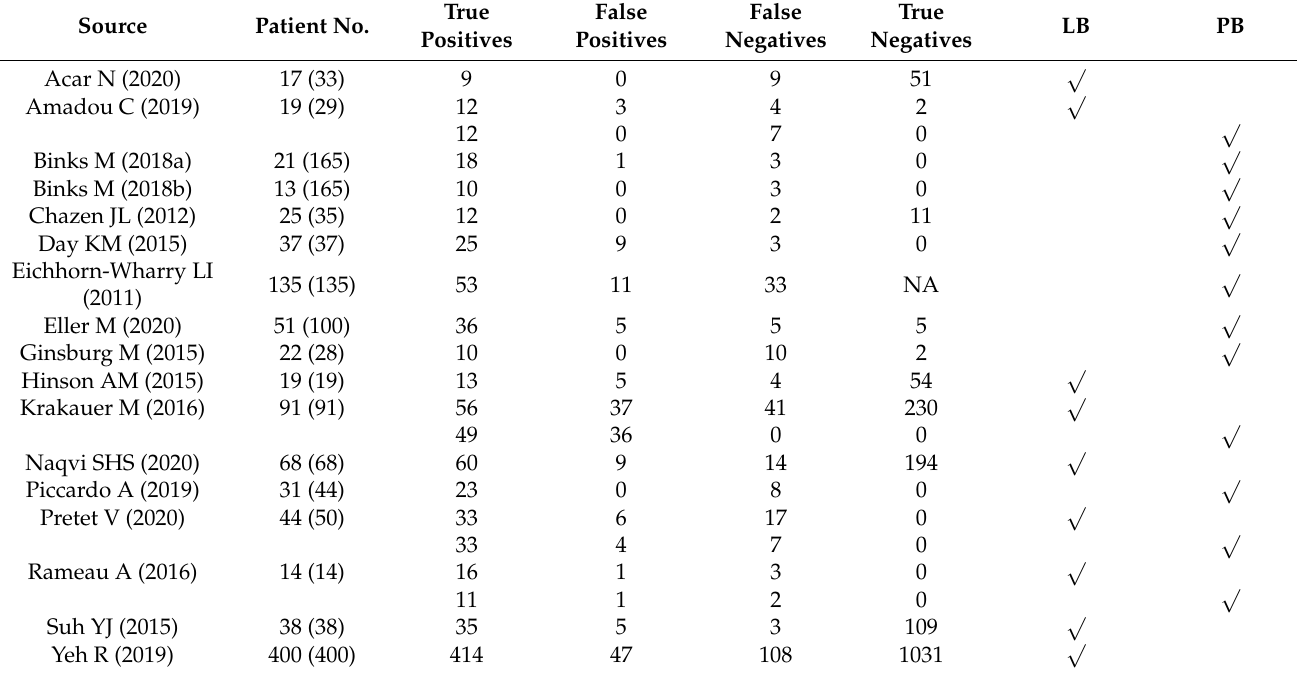
Table 3. Diagnostic accuracy of four-dimensional computed tomography (4D-CT) for localization of hyperfunctioning parathyroid glands